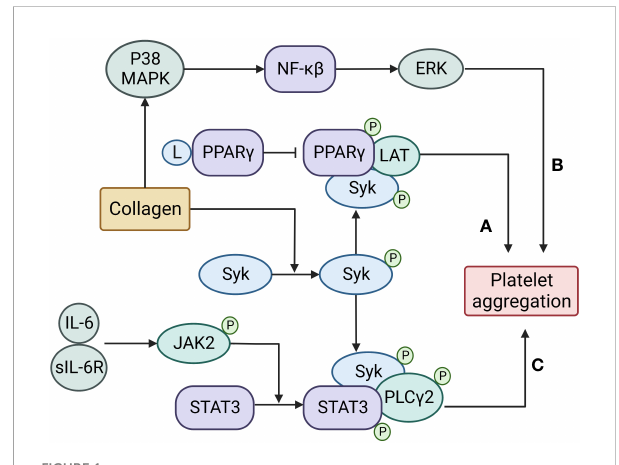
FIGURE 1 Transcription factors regulate platelet aggregation through non- transcriptional activities. (A) PPAR g is recruited and phosphorylated by Syk to promote the recruitment of LAT and enhance